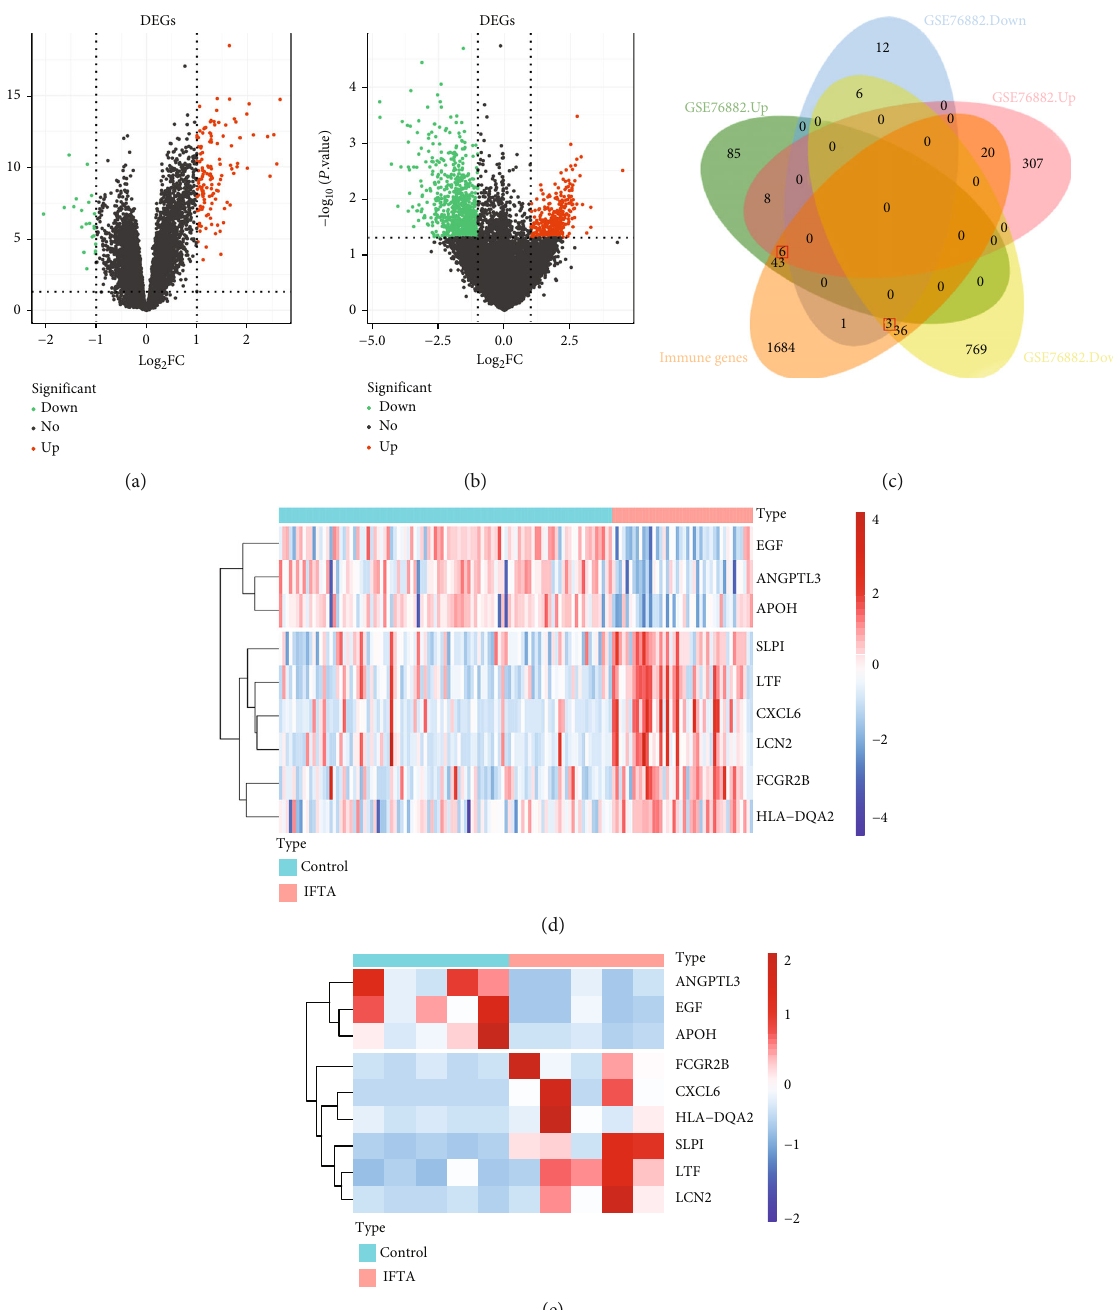
Figure 2: Identi fi cation of IF/TA-related DE-IRGs. (a and b) DEGs were identi fi ed from the GSE76882 and GSE120495 datasets. In the fi gures, each point represents a gene, and the green and red points represent the signi fi cantly di ff erentially expressed genes, and the red points represent upregulated di ff erentially expressed genes, while the green points represent downregulated di ff erentially expressed genes, and the black points represent no signi fi cantly di ff erentially expressed genes. (c) IRGs from the ImmPort database were compared to DEGs from above two datasets. The red box in the fi gure is the fi nal IFTA DE-IRGs, including 6 upregulated di ff erential immunity genes and 3 downregulated di ff erential immunity genes. (d and e) The heatmap of EGF , ANGPTL3 , APOH FCGR2B , CXCL6 , HLA- DQA2 , SLPI , LTF , and LCN2 genes in the IF/TA group. Each small square represents each gene, and its color represents the size of the gene expression. The greater the expression, the deeper the color (red is high expression and blue is low expression). The fi rst line represents sample grouping, lake blue represents control sample, and pink represents IF/TA sample. Each row represents the expression of each gene in di ff erent samples, and each column represents the expression of all genes in each